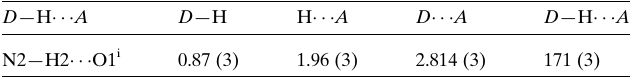
Table 1 Hydrogen-bond geometry (A˚ , (cid:2) ).